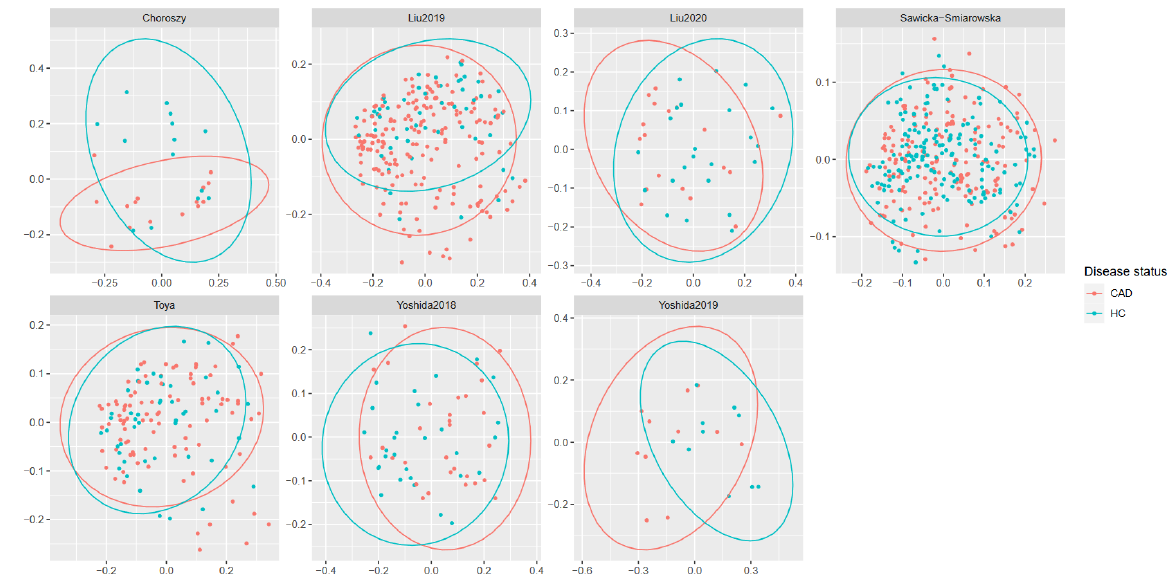
Figure 5 . Beta-diversity measured by UniFrac.